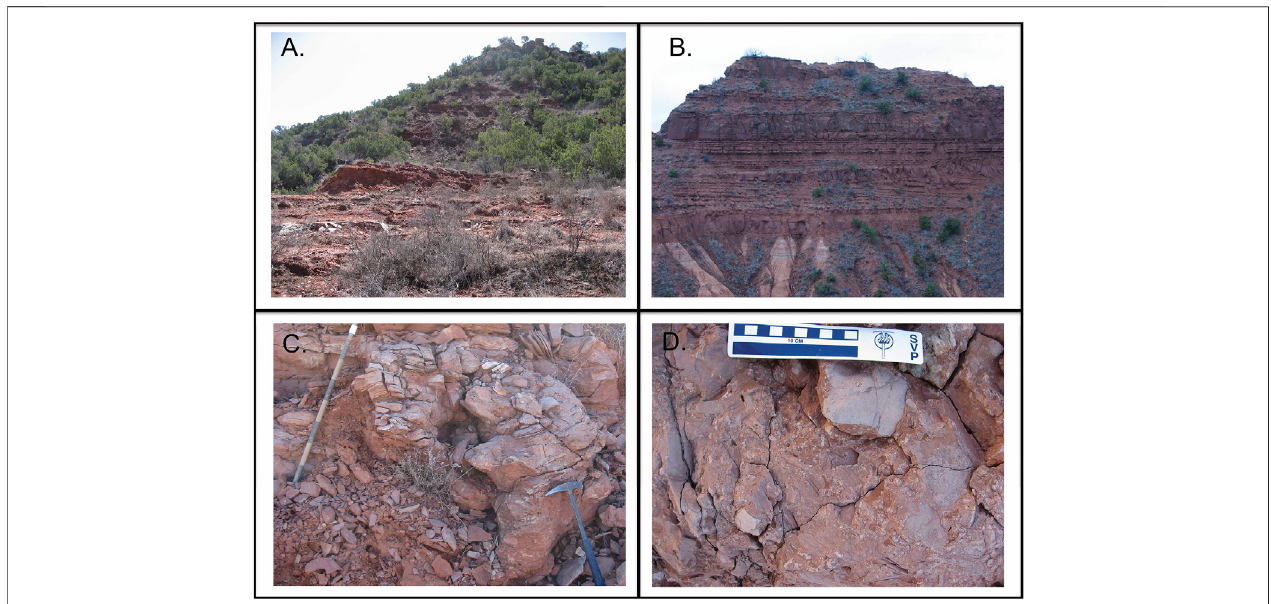
FIGURE 3 | (A) Outcrop of the Dickens stratigraphic section located along State Highway 114/82 ∼ 2 km west of the town of Dickens, TX U.S.A. Gypsiferous redbed of the salt-lake facies ( (cid:1) Whitehorse Group) belt are exposed in the foreground and the transition to lower Quartermaster Formation strata associated with the sand- fl at facies belt occurs in the top bench within the foreground. The lower ash in this stratigraphic section is exposed just behind the lower set of breaks on private property (the authors asked for, and received, permission to access this property for this study). (B) Outcrop of part of the Caprock Canyons stratigraphic section located in Caprock Canyons State Park near Quitaque, TX U.S.A. The lower pinkish-orange exposures are sandstone and mudstone facies of the sand- fl at facies belt. The upper strata are dominantly clinoform sandstone facies (note the low-angle cross strata in the middle of the outcrop) of the fl uvial facies belt. The low-angle cross strati fi ed beds in the middle of the outcrop is 7 m thick. (C) Limestone breccia fi lling karst fi ssures from exposure and dissolution of dolomite strata in the Whitehorse Groupstrataofthesalt-lakefaciesinoutcropsoftheHighway207roadcut.Thebrecciaisbestexposednexttotherockhammer(whichis40 cmlong)andisoverlainby thin-bedded dolomitic sandstones of the lower sand- fl at facies (adjacent to the Jacob ’ s staff, which has 10 cm divisions). (D) Close up of the karst- fi ll breccia exposed along the Highway 207 road cut.